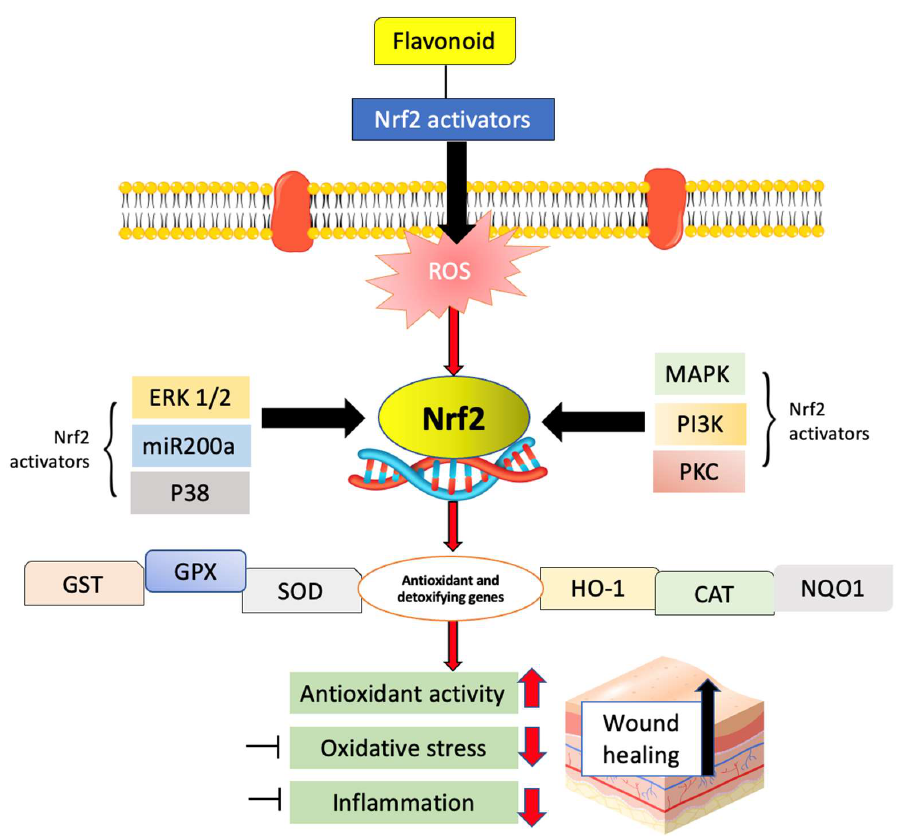
Figure 5. Potential mechanisms that Nrf2 activation affects wound healing. Flavonoids act as the Nrf2 activators that activate the ERK1/2, p38MAPK, PI3K, and PKC signaling pathways. Extracellular signal-regulated protein kinases 1 and 2 (ERK1/2), mitogen-activated protein kinases (MAPK), phosphoinositide 3-kinase (PI3K) and protein kinase C (PKC), glutathione S-transferase (GST), glutathione peroxidase 1 (GPX), superoxide dismutase type (SOD), heme oxygenase-1 (HO-1), catalase (CAT), and NAD(P)H quinone dehydrogenase 1 (NQO1). NF-κB is a transcription factor that regulates protein kinases, regulates cell activation and proliferation directly, and enhances the expression of several pro-inflammatory genes in cells [131]. Flavonoids inhibited the expression of nuclear factor kappa B (NF-kB) and reduced the levels of inflammatory mediators such as prostaglandin E2 (PGE2), leukotriene B4 (LTB-4), interleukin 1 (IL-1), tumor necrosis factor (TNF-), interleukin 6 (IL-6), and interferon (IFN-) [88]. Supplementation with luteolin significantly reduced protein expressions of inflammatory factors such as matrix metalloproteinase (MMP)-9, tumor necrosis factor (TNF)-, interleukin (IL)-6, and IL1-. Additionally, luteolin downregulated nuclear factor (NF)-B while also inducing increases in anti-oxidative enzymes such as superoxide dismutase 1 (SOD1) and glutathione peroxidase (GSH-Px) [132]. 6.7. Mitogen-Activated Protein Kinase/Extracellular Signal-Regulated Kinase (MAPK/ERK) and Phosphatidylinositol 3-Kinase (PI3K)/Protein Kinase B (P13/AKT) Pathway Mitogen-activated protein kinase/extracellular signal-regulated kinase (MAPK/ERK) signaling is heavily involved in the regulation of cell migration and proliferation.